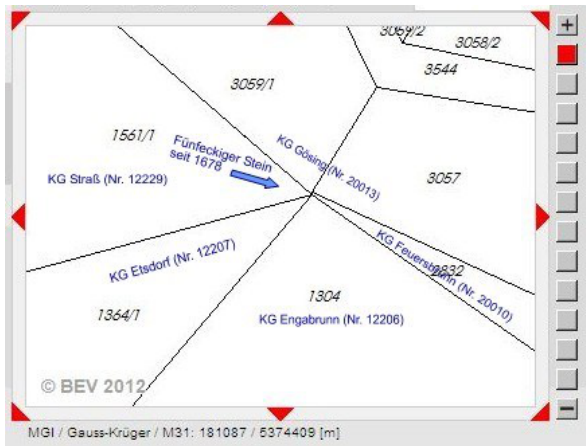
Figure 4. Extract from the cadastral map of today, showing the multi-crossing of the pentagonal boundary stone (Source